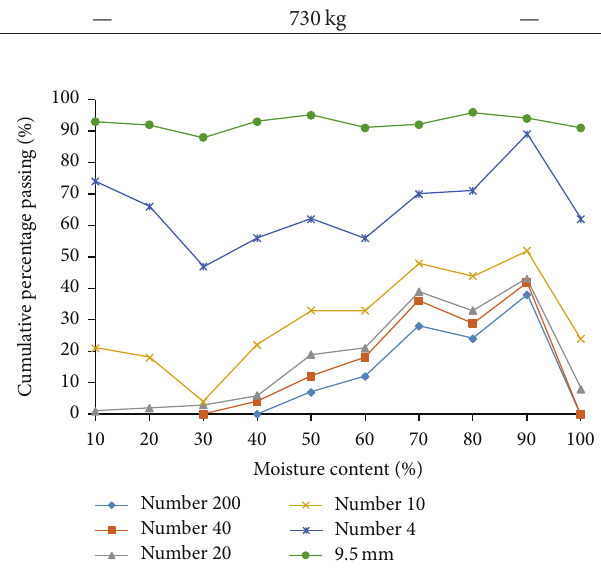
Figure 1: Sieve passing percentage according to both moisture content and particle distribution.